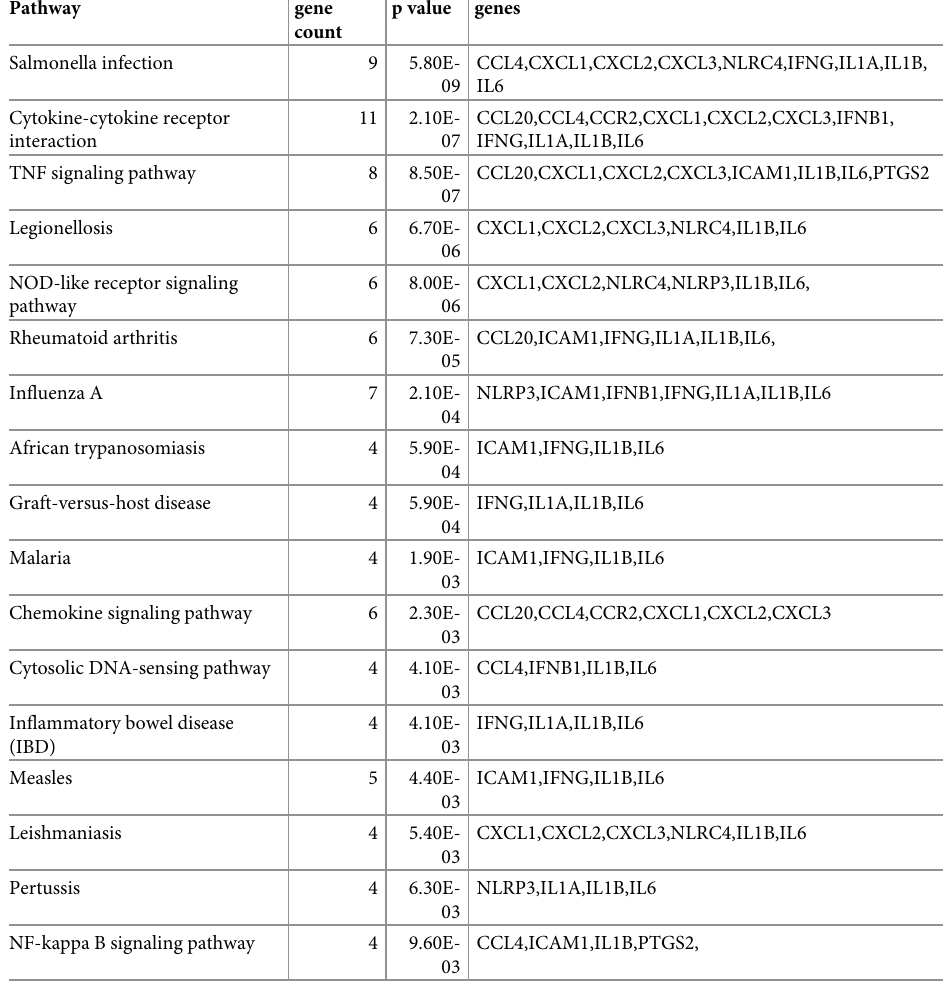
Table 3. Interrelation between overlapping DEGs and enriched KEGG